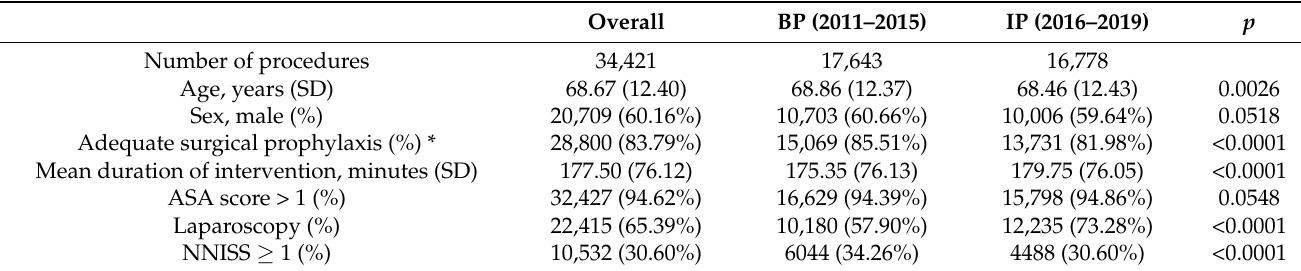
Table 2. Colorectal surgery characteristics of the patients included in the study